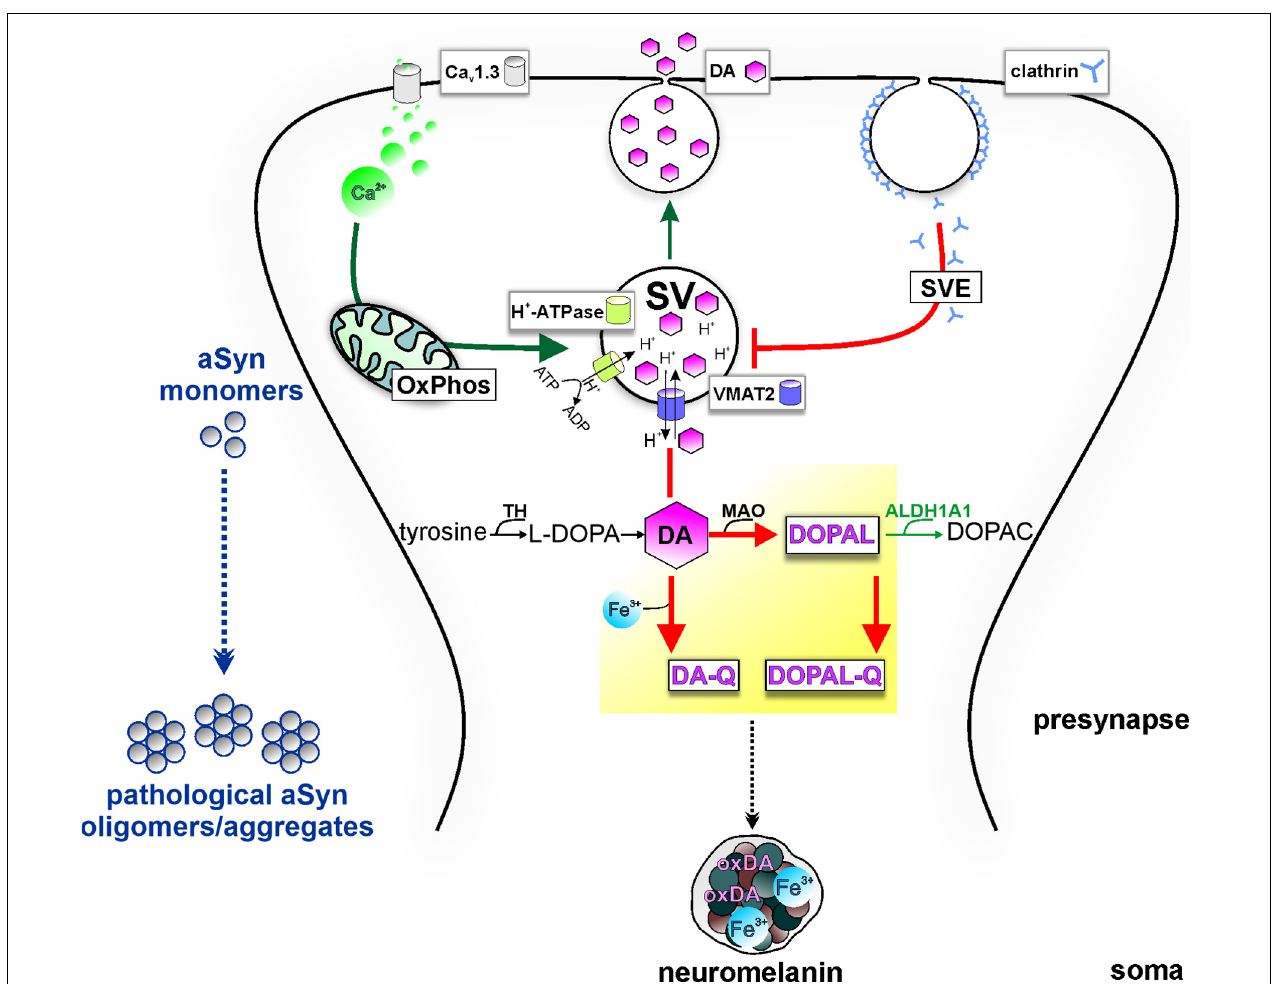
FIGURE 2 | Potential model of the intersection of PD vulnerability pathways with DA metabolism at presynapse, promoting aSyn aggregation. Pre-synaptic calcium influx ( via Ca v 1.3 calcium channels) drives mitochondrial oxidative phosphorylation (OxPhos), energetically supporting DA sequestration (thick green arrow) and consecutively neurotransmission. Synaptic vesicles (SVs) are loaded with DA neurotransmitter by VMAT-2, which transports cytosolic DA into the SV in exchange of H + provided by the action of the H + -ATPase. Following release, synaptic vesicle endocytosis (SVE) replenishes SVs; however, PD-linked deficits in this pathway can limit the SV availability (thick red line). Because of ongoing DA biosynthesis (TH-catalyzed conversion of tyrosine to L-DOPA), impairment of DA sequestration into SVs leads to the accumulation of DA in the cytosol (thick red line). Subsequent build-up of oxidized DA metabolites (yellow highlight) in the cytosol disturbs aSyn homeostasis and leads to neurotoxicity. Specifically, cytosolic DA oxidation, catalyzed by iron (Fe 3 + ), can lead to increased oxidized DA derivatives (oxDA), as well as increased levels of the neurotoxic metabolite DOPAL, catalyzed by MAO, further oxidized to DOPAL-Q (thick red arrows). aSyn oligomerization by DOPAL/-Q entails formation of adducts, whereas binding of DA-Q, calcium, and iron also promote the formation of aSyn oligomers/aggregates. Neuronal detoxification from DOPAL is mediated by ALDH1A1, which catalyzes its conversion to the non-toxic metabolite DOPAC (thin green arrow). Moreover, DA-Q and iron are removed from the cytosol over time by sequestration to the dark pigment neuromelanin at the soma (black intermittent arrow), enclosed within membranes, which can be neuroprotective under physiological